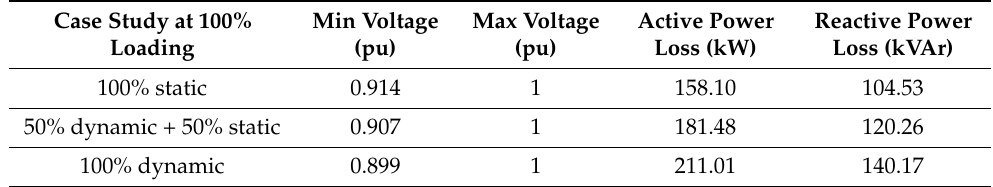
Table 1. Comparison between static and dynamic loads at 100% loading, i.e., a total load of (3581 + j1745) kVA.